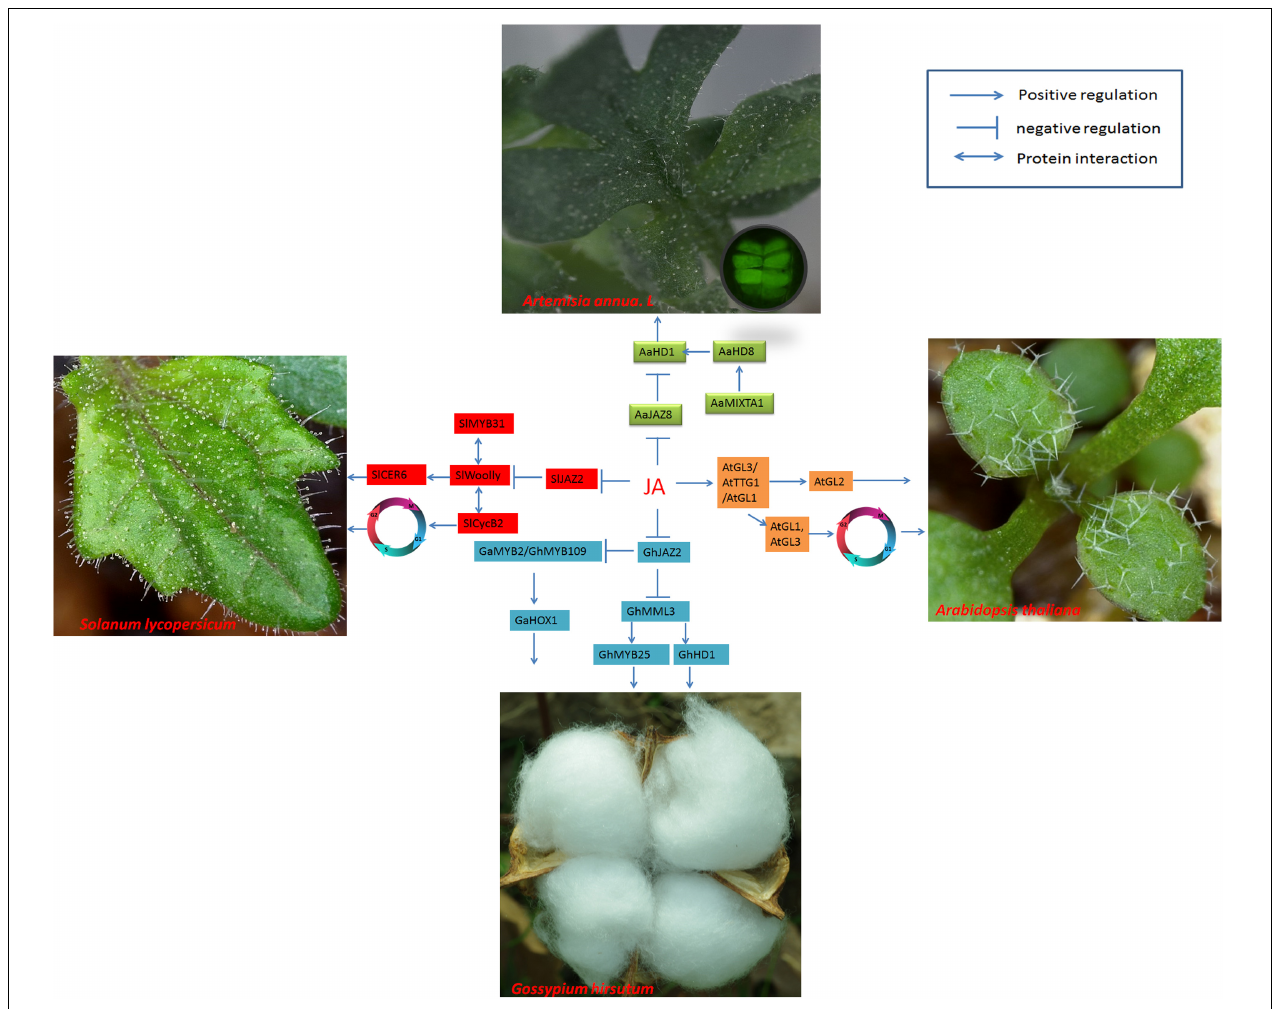
FIGURE 3 | Regulatory networks of cotton fiber and trichome development induced by JA. JAZ proteins are degraded when JA levels increase, releasing ARFs and activating transcription factors such as AaHD1 in A. annua , SlWoolly in tomato, and GhMML3 or GhMYB109/GhMYB2 in cotton, thus regulating trichome development or fiber initiation. JA regulates trichome development by affecting the BMW complex to promote the expression of AtGL2 in Arabidopsis. AtGL1 and AtGl3 are involved in cell endoreduplication and induce trichome development. In the development of tomato trichomes, the cyclin protein SlCycB2 interacts with SlWoolly to modulate trichome initiation. SlMYB31 regulates trichome development by modulating lipid loading in